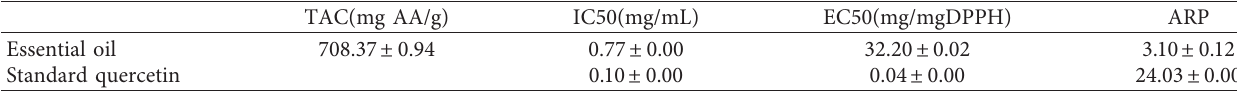
Table 7: Total antioxidant capacity (TAC), inhibitory concentration (IC the Halimium halimifolium’s essential oil.